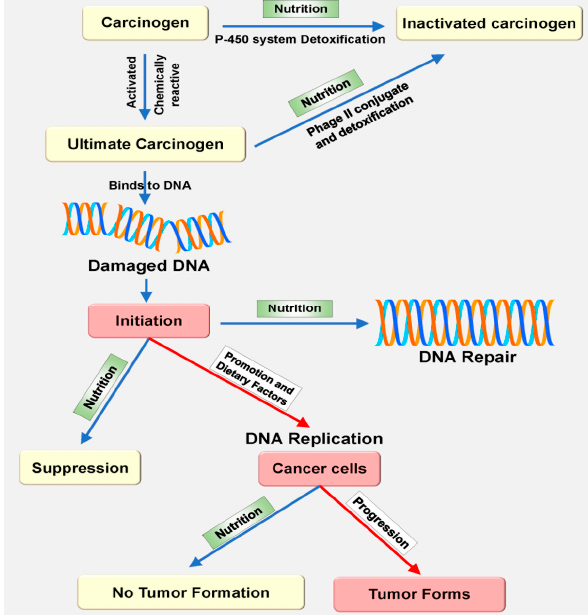
Figure 3. Nutrition as a mediator of cancer suppression at the molecular level. A chemically reactive